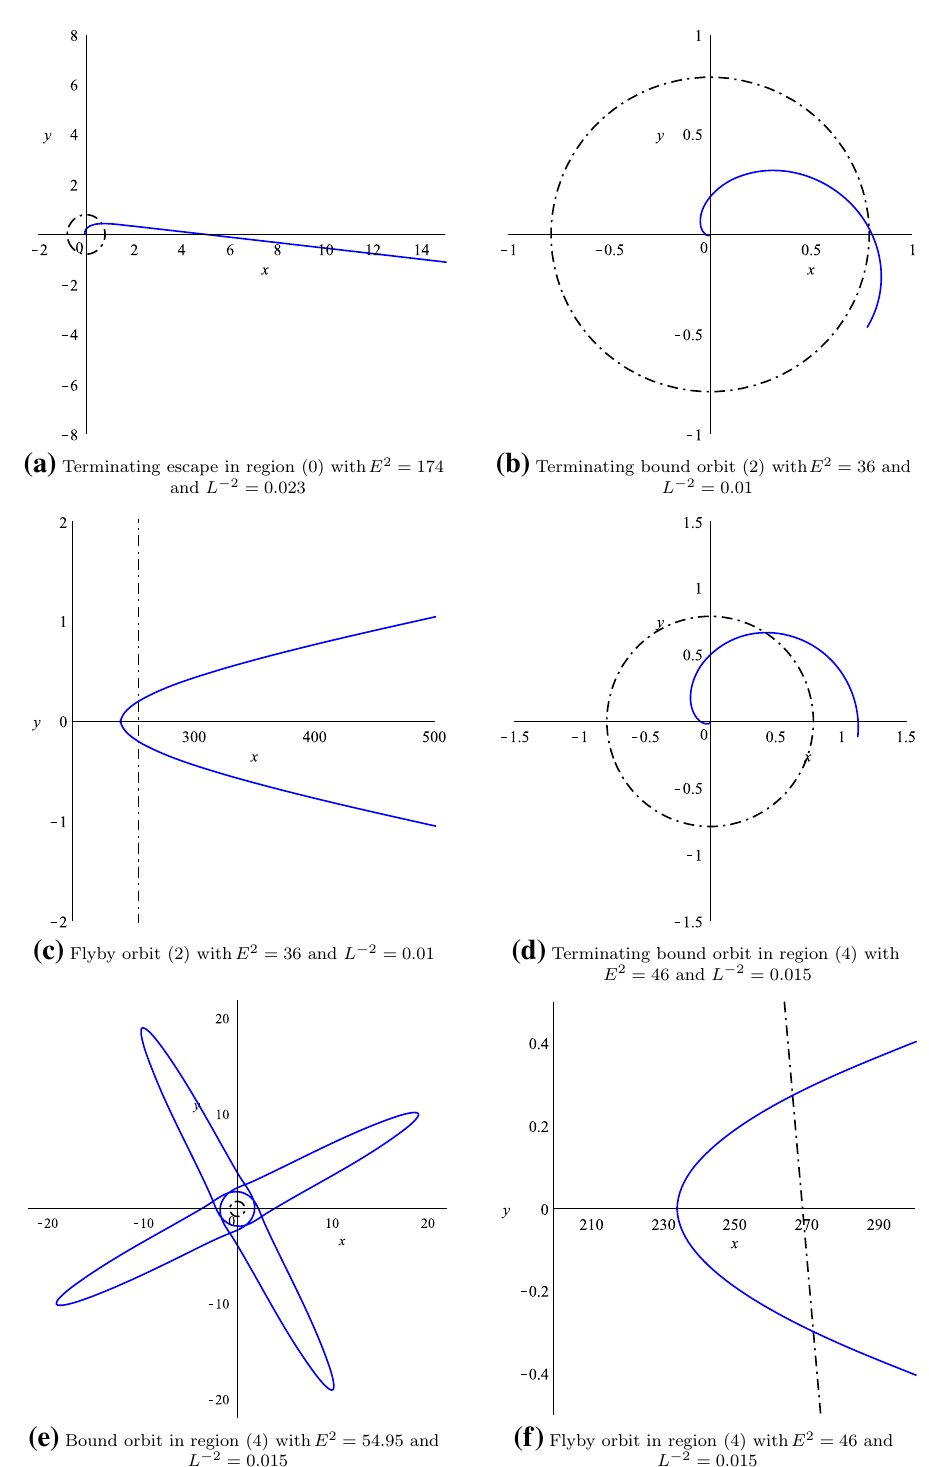
Fig. 9 Timelike geodesics in the uncharged BTZ black hole in massive gravity with (cid:4) = 0 . 01, m (cid:5) = 2 . 54 and m 0 = 2. The dashed dot line represents